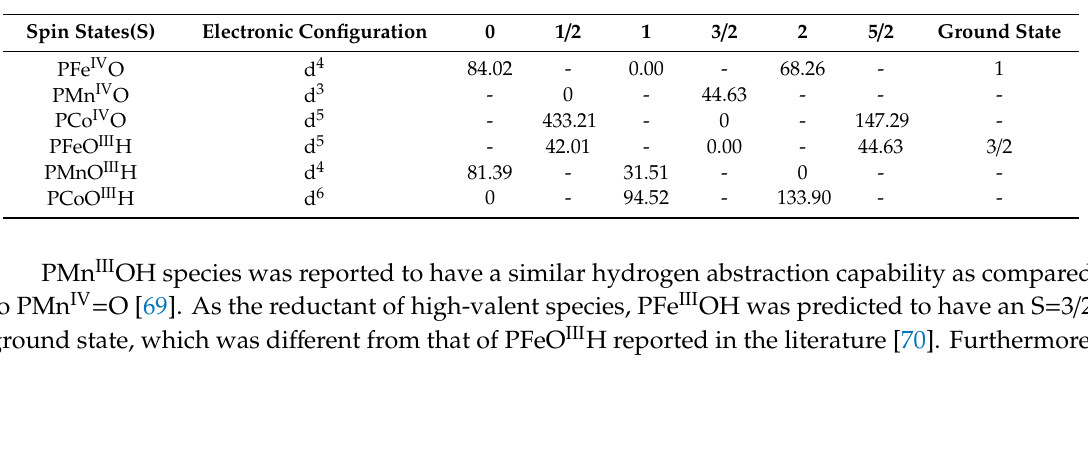
Table 3. Relative energies of PM IV O and PM III OH (M = Fe, Mn, and